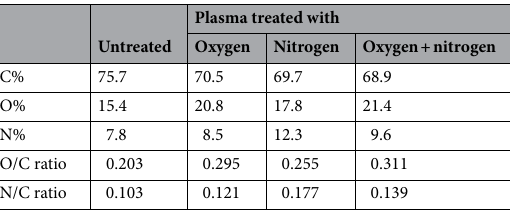
Table 1. Surface elements of variously pretreated polyamide-6,6 fabrics.